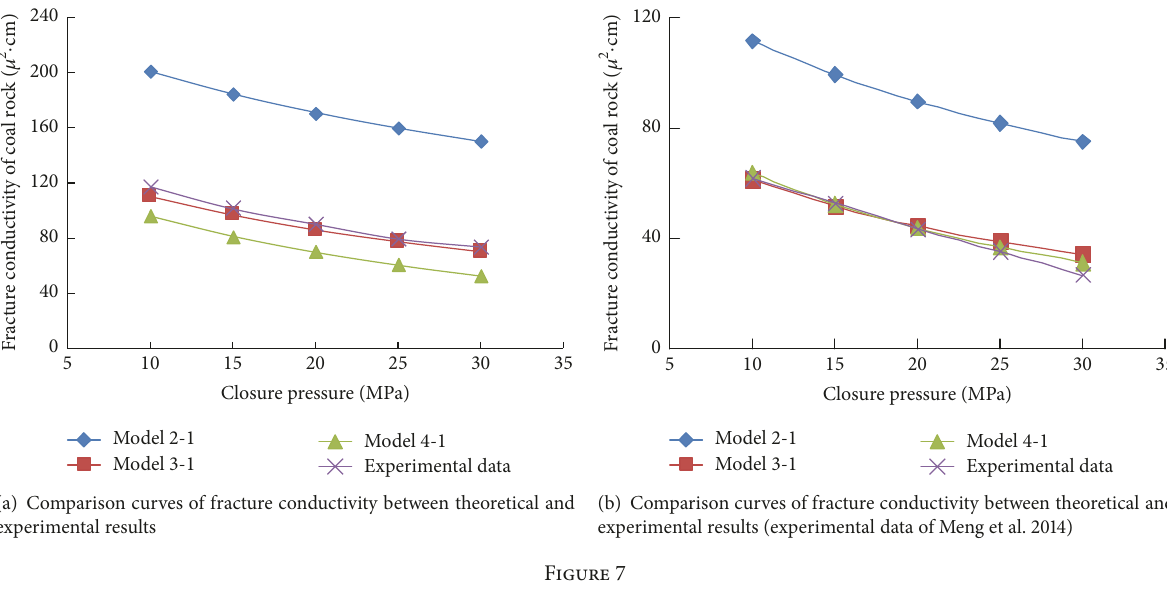
(b) Comparison curves of fracture conductivity between theoretical and experimental results (experimental data of Meng et al. 2014)